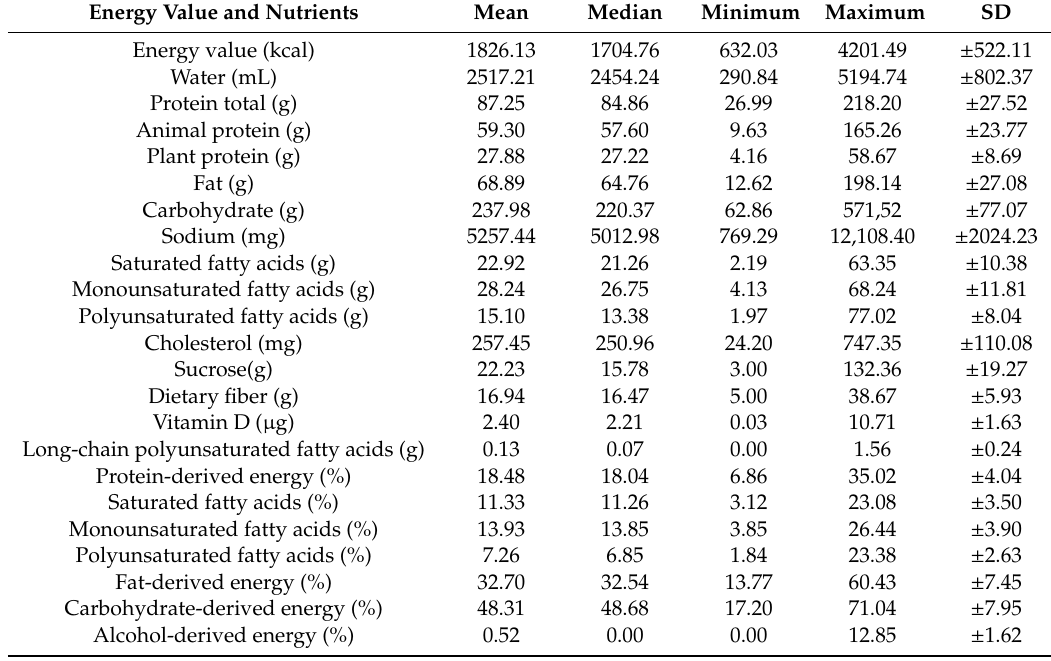
Table 3. Energy and selected nutrients intake (per day) based on the IFQ in the study group. Energy Value and Nutrients